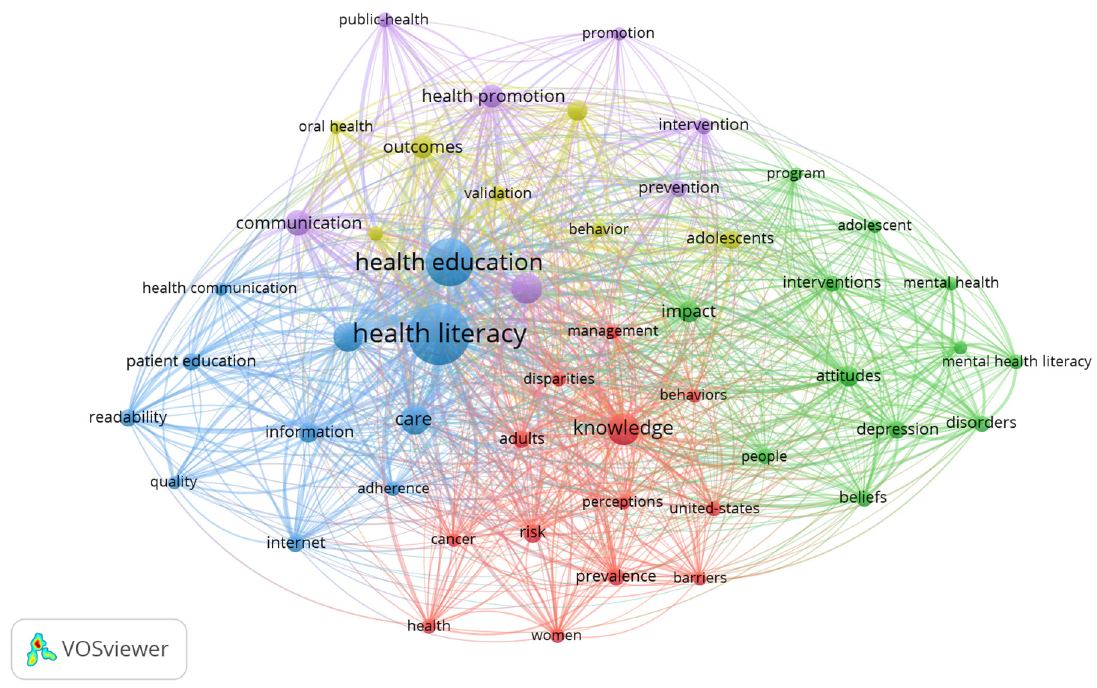
Figure 12. Network map of 50 keywords with a frequency of more than 20 occurrences.